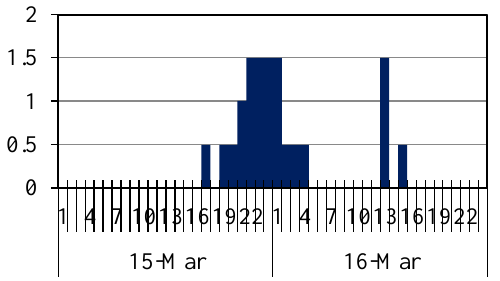
Figure 5. Hyetograph on March 15 to 16 at objective area